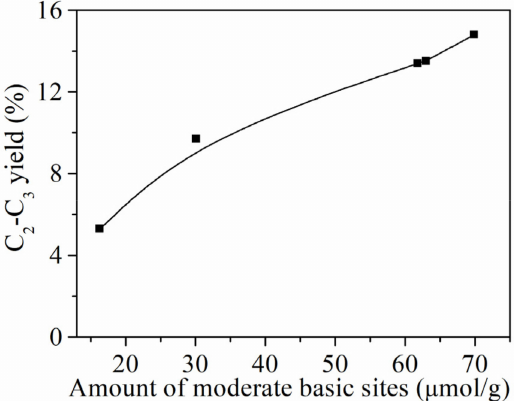
Figure 10. Relationship between the C 2 -C 3 yield obtained at 700 ◦ C and the amount of moderate basic sites present on the Ho 2 O 3 -based